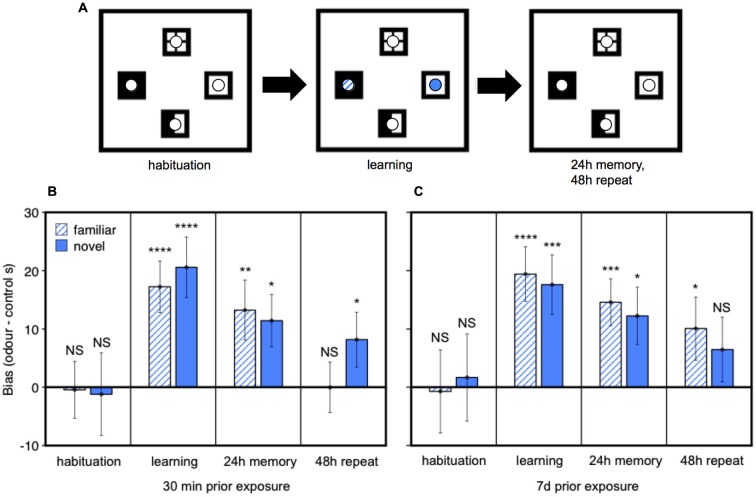
Effect of prior exposure on female attraction to male urine and conditioned place preference responses. After pre-exposure in the home cage to urine from a wild-stock male, females were tested in a clean arena with four locations marked by visually distinctive floor tiles bearing small petri dishes (A). On the learning day, one dish contained male urine streaks familiar from the home cage treatment, one dish contained urine from a novel male and two dishes contained water streaked as a control. Conditioned place preference tests were conducted after 24 h and 48 h when all dishes contained water streaks. Data show the bias in time spent in urine locations minus the average time spent in control locations (mean ± sem, n = 19 per treatment) among females pre-exposed in the home cage to male urine for 30 min (B) or 7 days (C). Asterisks indicate greater bias towards a urine stimulus location than water controls (*P < 0.05, **P < 0.01, ***P < 0.005, ****P < 0.001).